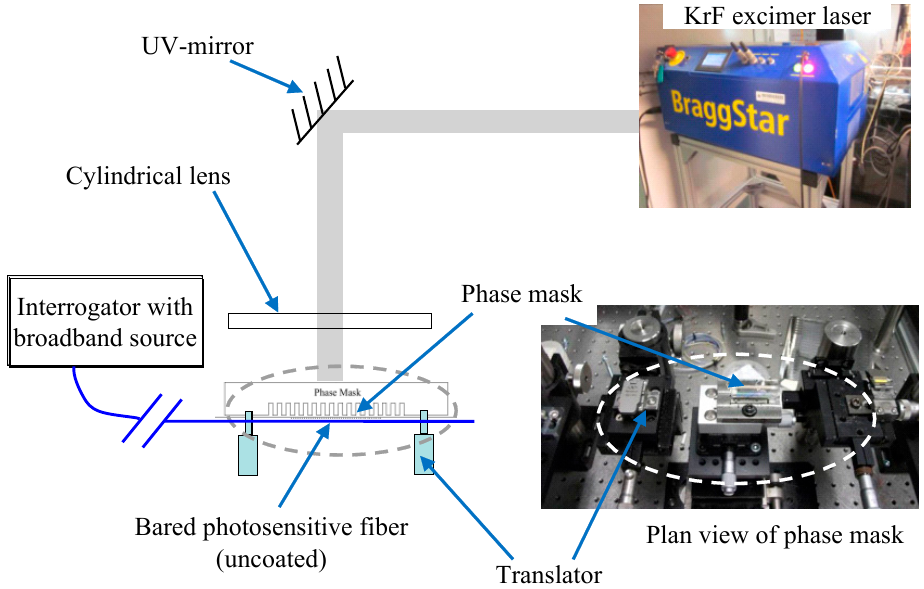
Figure 2. Experimental setup for fabricating FBG sensors by the phase mask method [23].